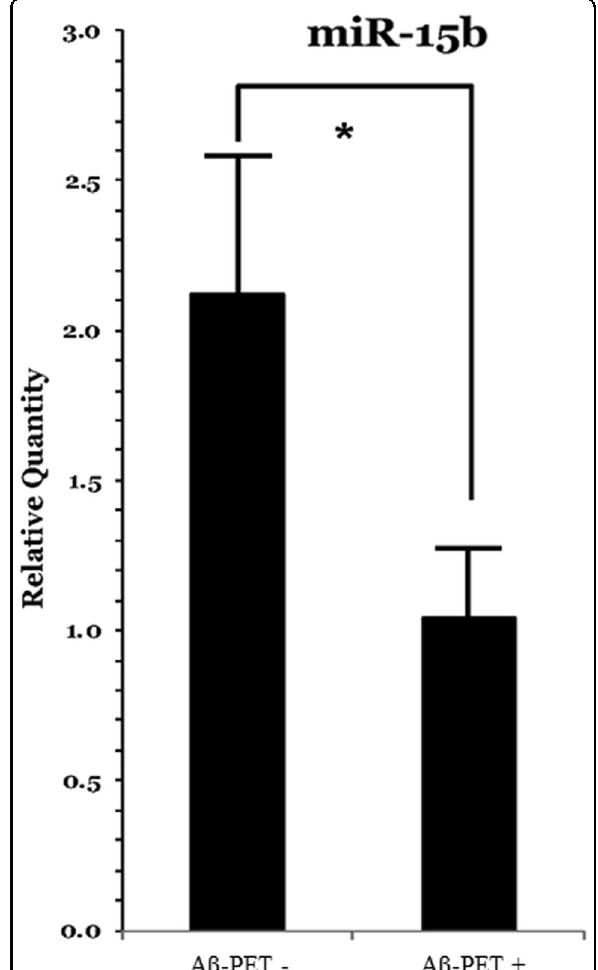
Fig. 1 miRNA15b is signi fi cantly lower in the A β -PET negative subgroup compared with the A β -PET positive. *Kruskal – Wallis one-way ANOVA on ranks test; p value: 0.045 (see Table 1 for descriptive data). Plasma miR-15b concentration is reported in terms of relative quantity. PET positron emission tomography, A β amyloid beta, n.s. not signi fi cant, miRNA